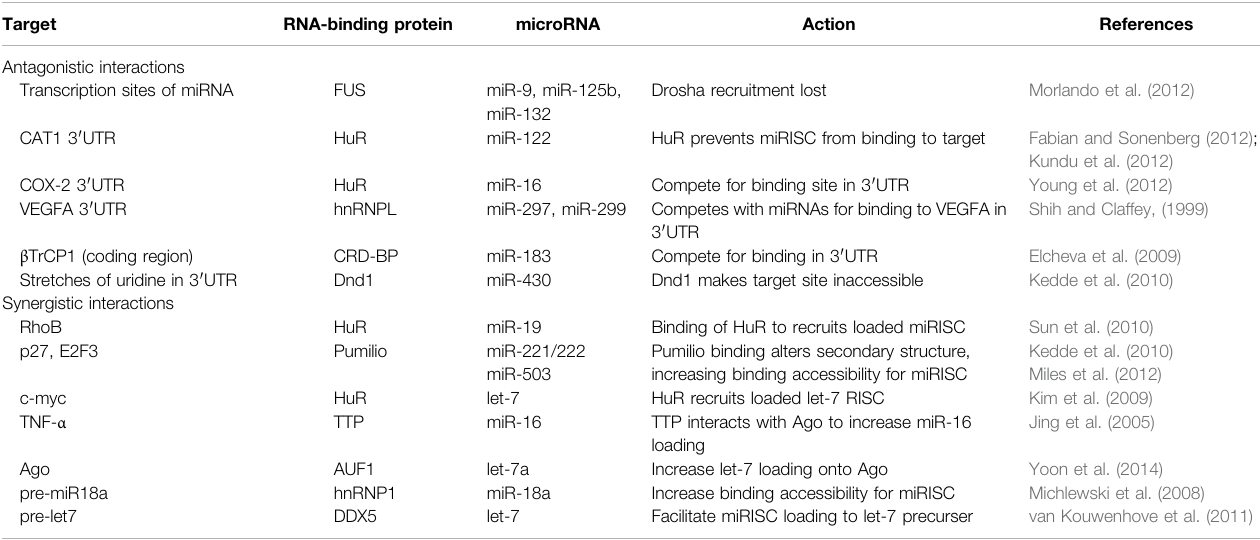
TABLE 1 | Known interactions of RNA-binding proteins and